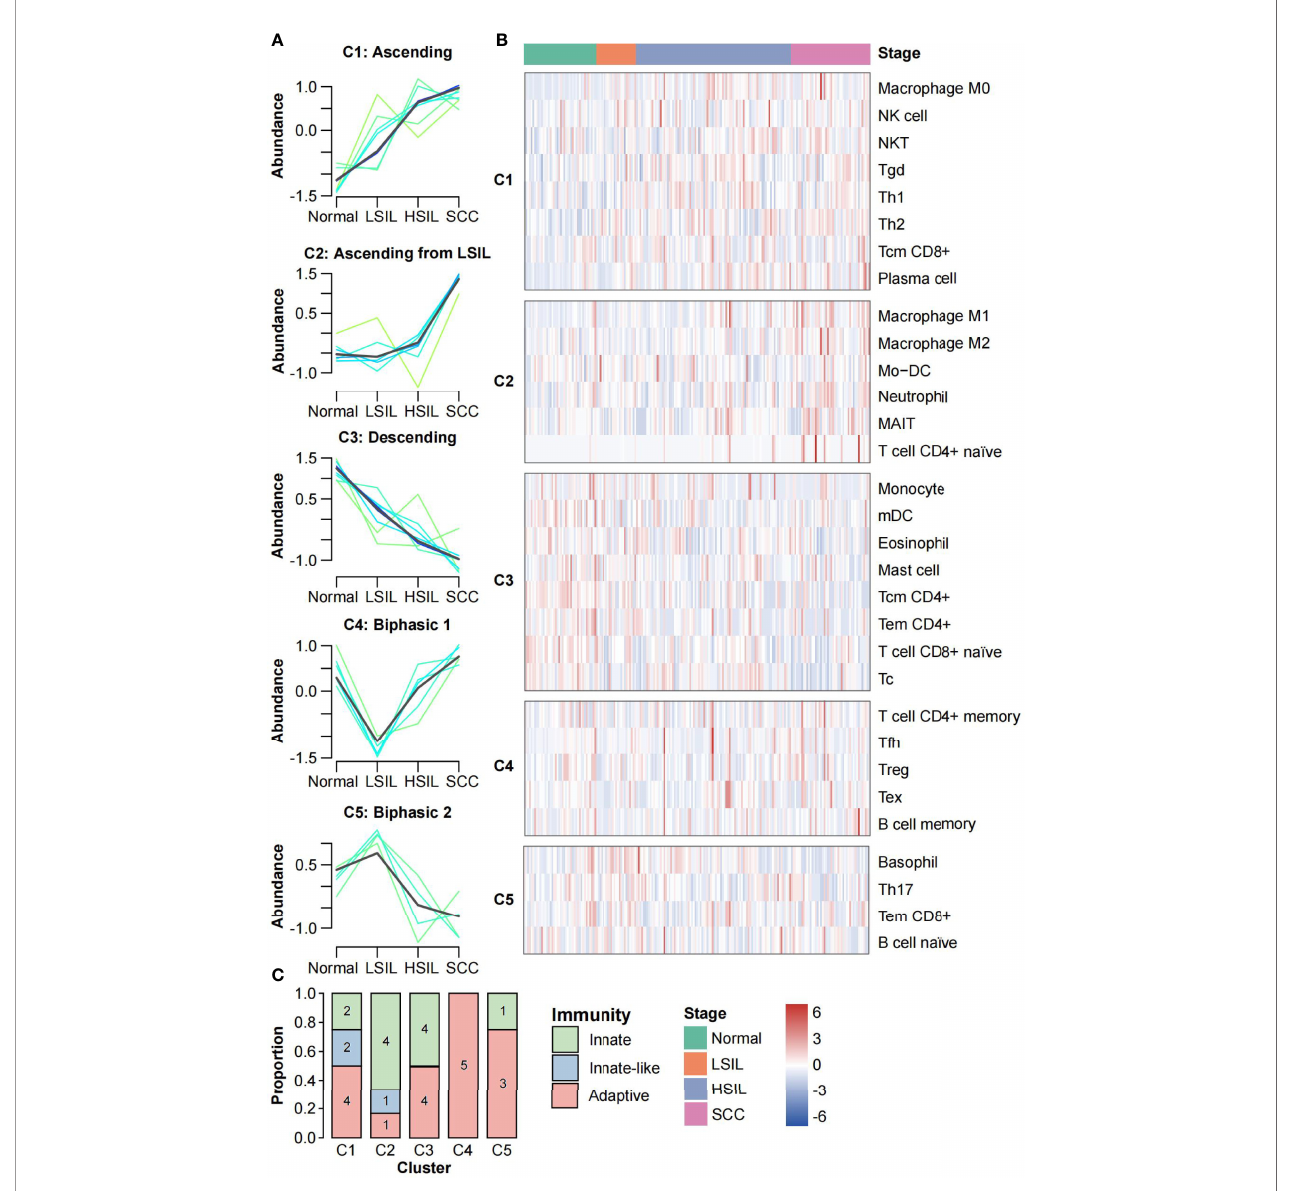
FIGURE 4 | Clustering analysis of immune cells abundance. (A) FCM clustering identi fi ed fi ve distinct clusters of immune cell in fi ltration patterns. Each line indicates the abundance of one immune cell and is colored by membership value. Green colored lines correspond to cells with low membership values. Bule and cyan colored lines correspond to cells with moderate membership values. The line for each cluster centre is plotted in black. The x axis represents disease stages; the y axis represents abundance changes. (B) Stage-ordered heatmap showing abundance changes of 31 immune cell types in meta-dataset. The groups were divided according to the clustering results of FCM algorithm. (C) Stacked bar plot of the number of immune cells in each category (innate, innate-like, and adaptive) for each